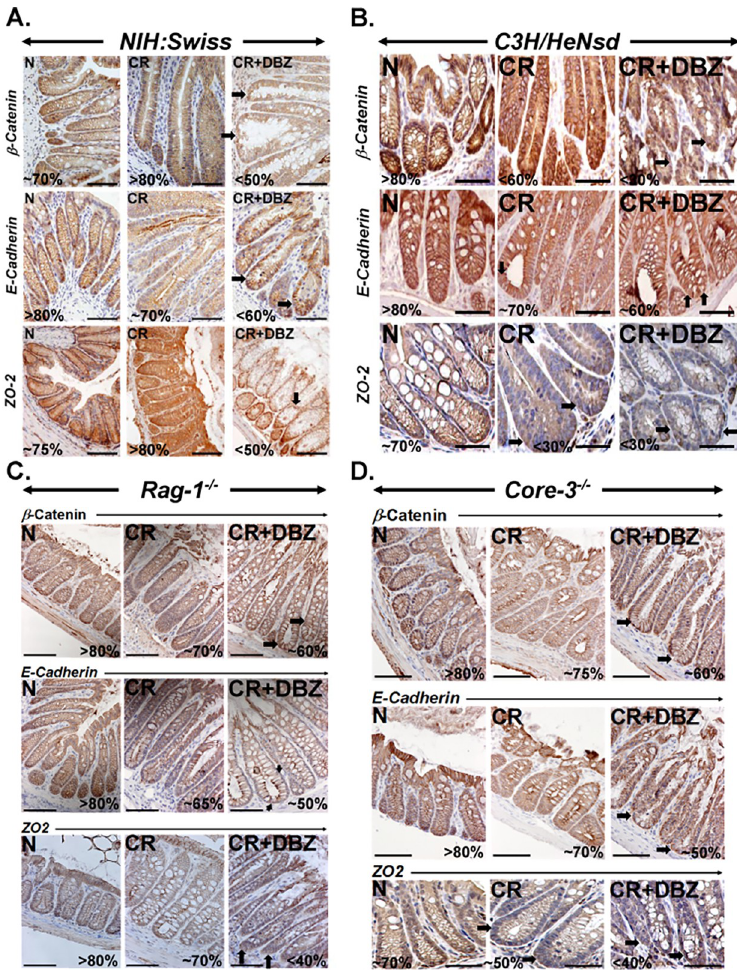
Fig 4. Chronic Notch inhibition and tight and adherens junction integrity. Paraffin-embedded sections prepared from the colons of uninfected (N), CR-infected (CR) and CR+DBZ-treated NIH : Swiss , C3H , Rag-1 -/- and Core-3 -/- mice were stained for β -catenin, E-cadherin and ZO-2, respectively. Arrows highlight the significant loss of these proteins in CR infected or CR+DBZ-treated colons. Bars = 100 μ m; n = 3 independent